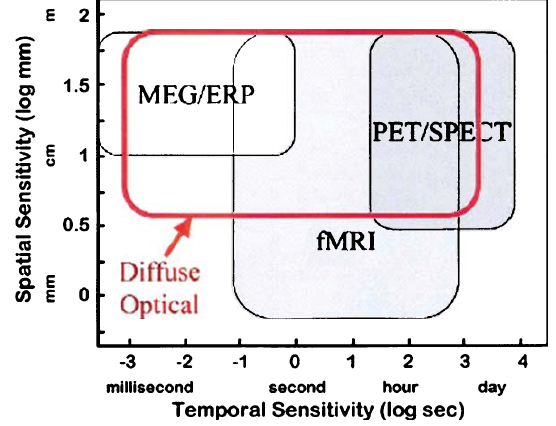
Fig. 4. Comparison of different imaging modalities in terms of their spatial and temporal sensitivities (after [4]).